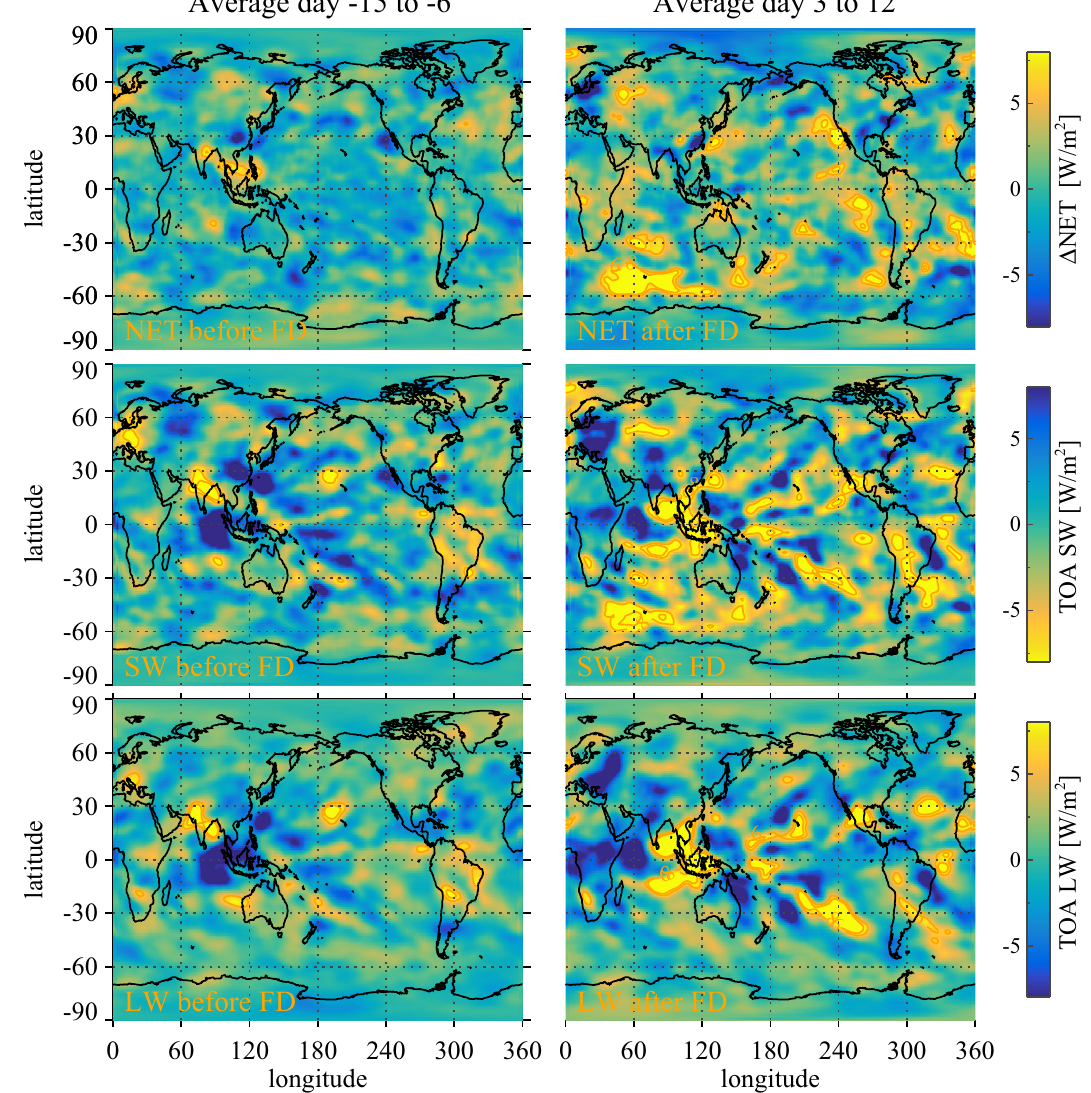
Figure 4. The left-hand column represents variations in the average radiative state before the FD (for details see Methods) averaged over the first nine days before the FD minimum for the NET, SW, and LW, respectively, and the right-hand column is the variations in the average radiative state after the FD averaged over nine days after the FD starting on day 3. Top panels are NET radiation. Middle panels are for SW radiation, and finally, the bottom panel is LW Figure 1 offers insight into the response of the terrestrial cloud system during strong FDs. The global signals (purple curves) of the TOA NET, and SW radiation in Fig. 1 show a significant response, reaching a 2–3 W/ m 2 perturbation around 5 days after the FD minimum. An increase is seen in the NET radiation, while the SW exhibits a complementary decrease. Notably, the LW component in the bottom panel shows no response to the FDs. By applying cloud masks selecting for either liquid cloud or for high clouds, it is possible to understand the response. Considering first the liquid clouds (red curves), the signals in the NET and SW radiation in Fig. 1 persist and even strengthen, while the LW component remains almost unaffected. The explanation is that liquid clouds are low clouds, and therefore the difference between cloud top temperature and Earth’s surface temperature is relatively small. Thus, a decrease in liquid cloud fraction would manifest as a nearly unchanged LW signal. In contrast, liquid clouds affect SW radiation, which increases NET-absorbed radiation. This scenario is corrobo- rated by using the Fu-Liou radiative transfer model 26,27 using input of simultaneous measured MODIS liquid cloud parameters ( cloud fraction, cloud optical thickness, and effective cloud droplet radius) as displayed in Fig. 1b for SW changes (gray curve) and Fig. 1c for LW (gray curve). Applying a cloud mask to extract high cloud regions leads to a different result (Fig. 1, cyan curves). Here, the response in NET radiation is relatively smaller and less significant. However, the effects in the SW and LW